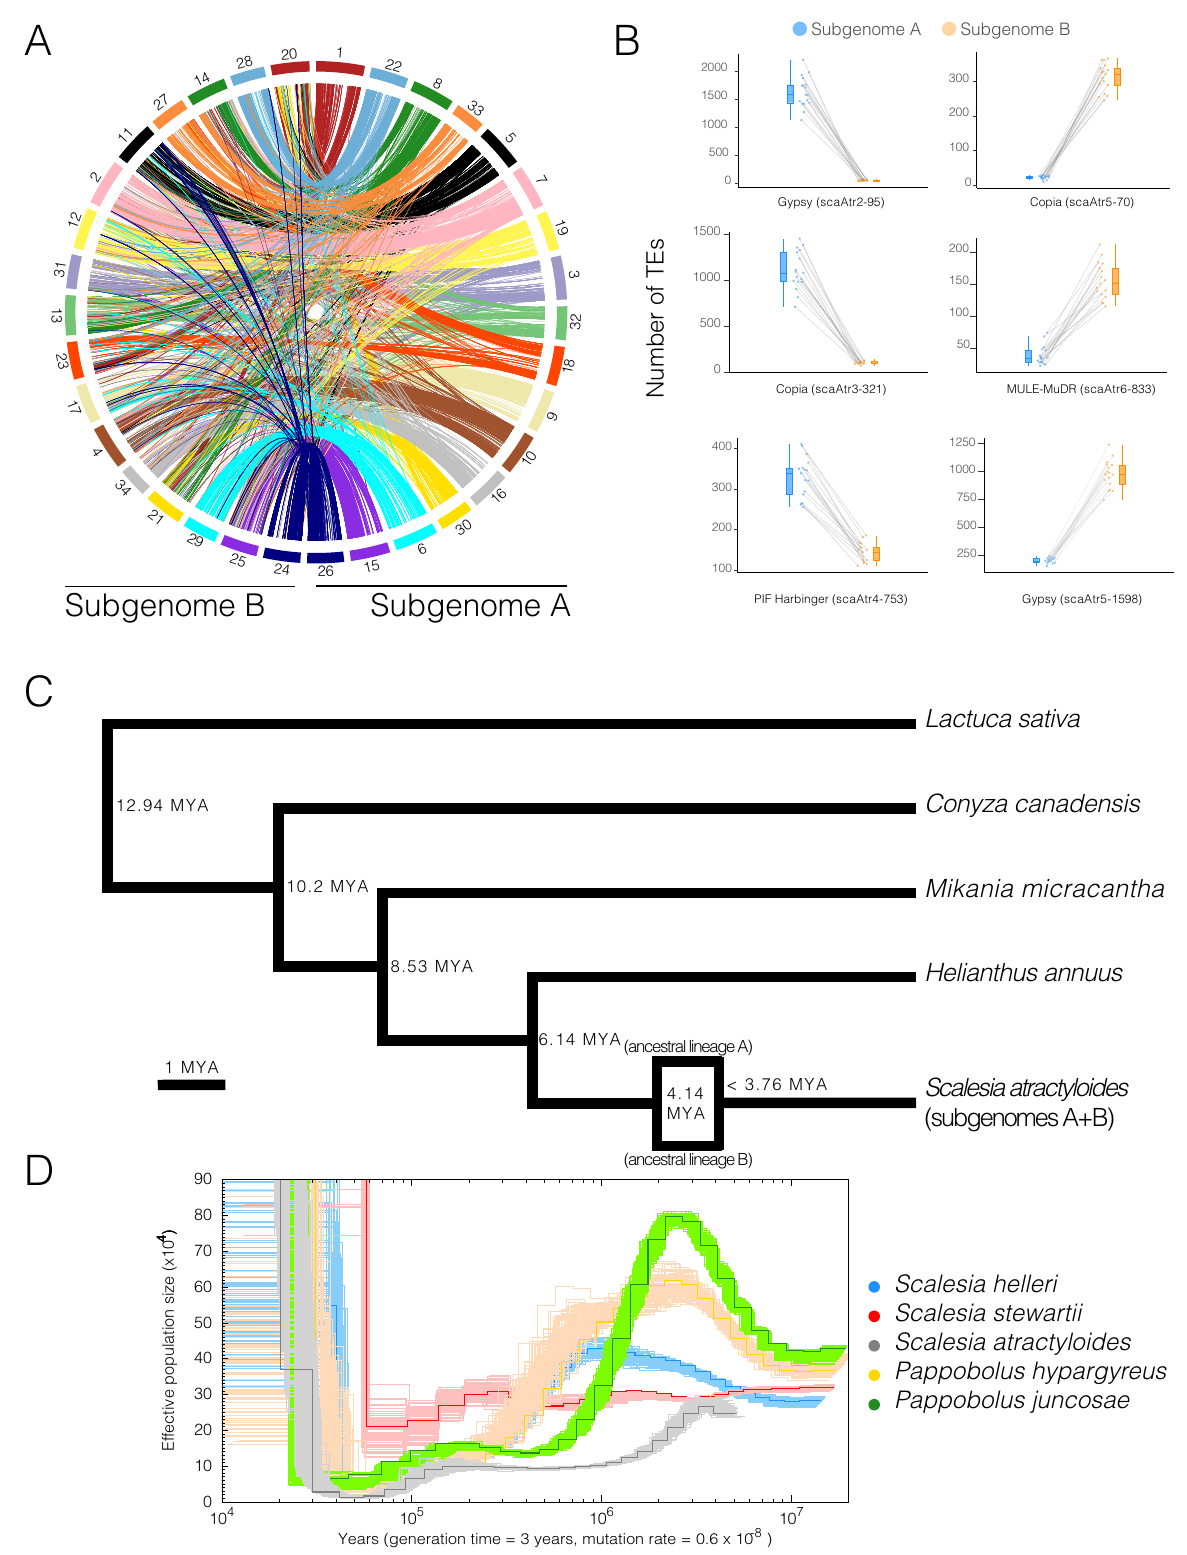
Genome rearrangements in Heliantheae . To further dissect the mode and tempo of polyploid subgenome evolution, we used Synolog 42 to create chromosome stability plots, which allow us to detect translocations and inversions (Fig. 4). Synolog establishes clusters of conserved synteny by identifying single-copy orthologs shared between two genomes via reciprocal all-by-all